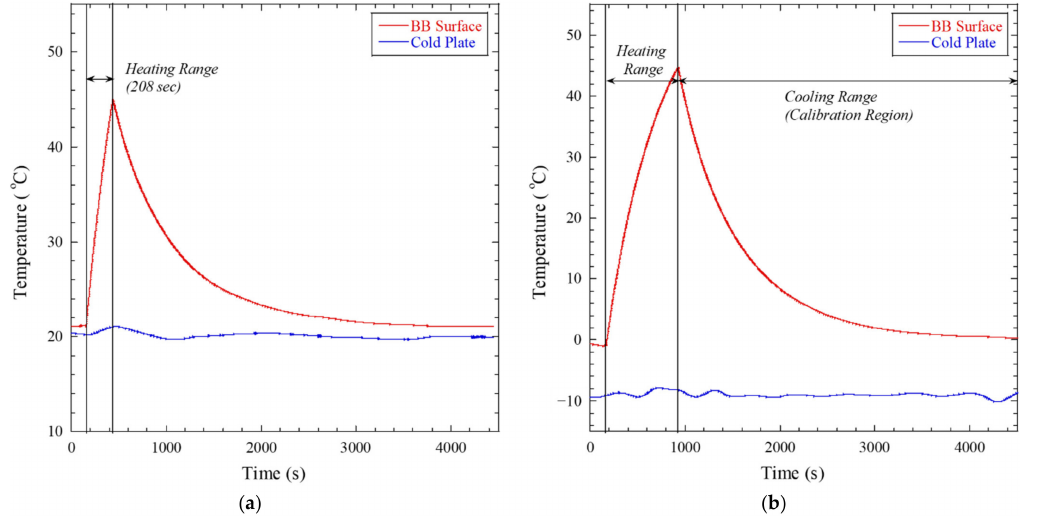
Figure 14. Temperature profile on BB surface measured using temperature sensors: ( a ) 20 °C boundary condition; ( b ) 0 °C boundary condition.